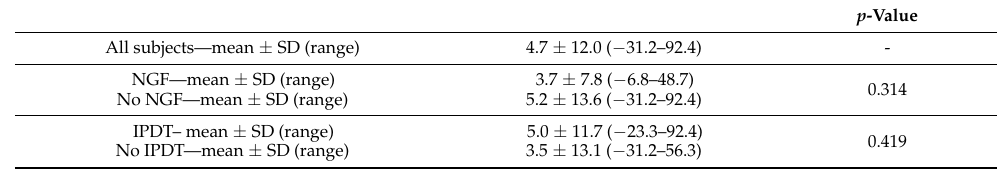
Table 3. Multivariate logistic regression (dependent variable: enteral nutrition administered).